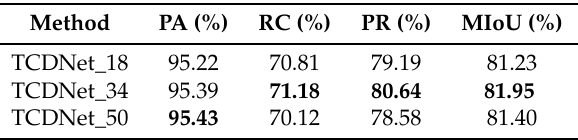
Table 2. Influence of convolutional neural networks (CNNs) with different depths on algorithm performance (bold represents the best